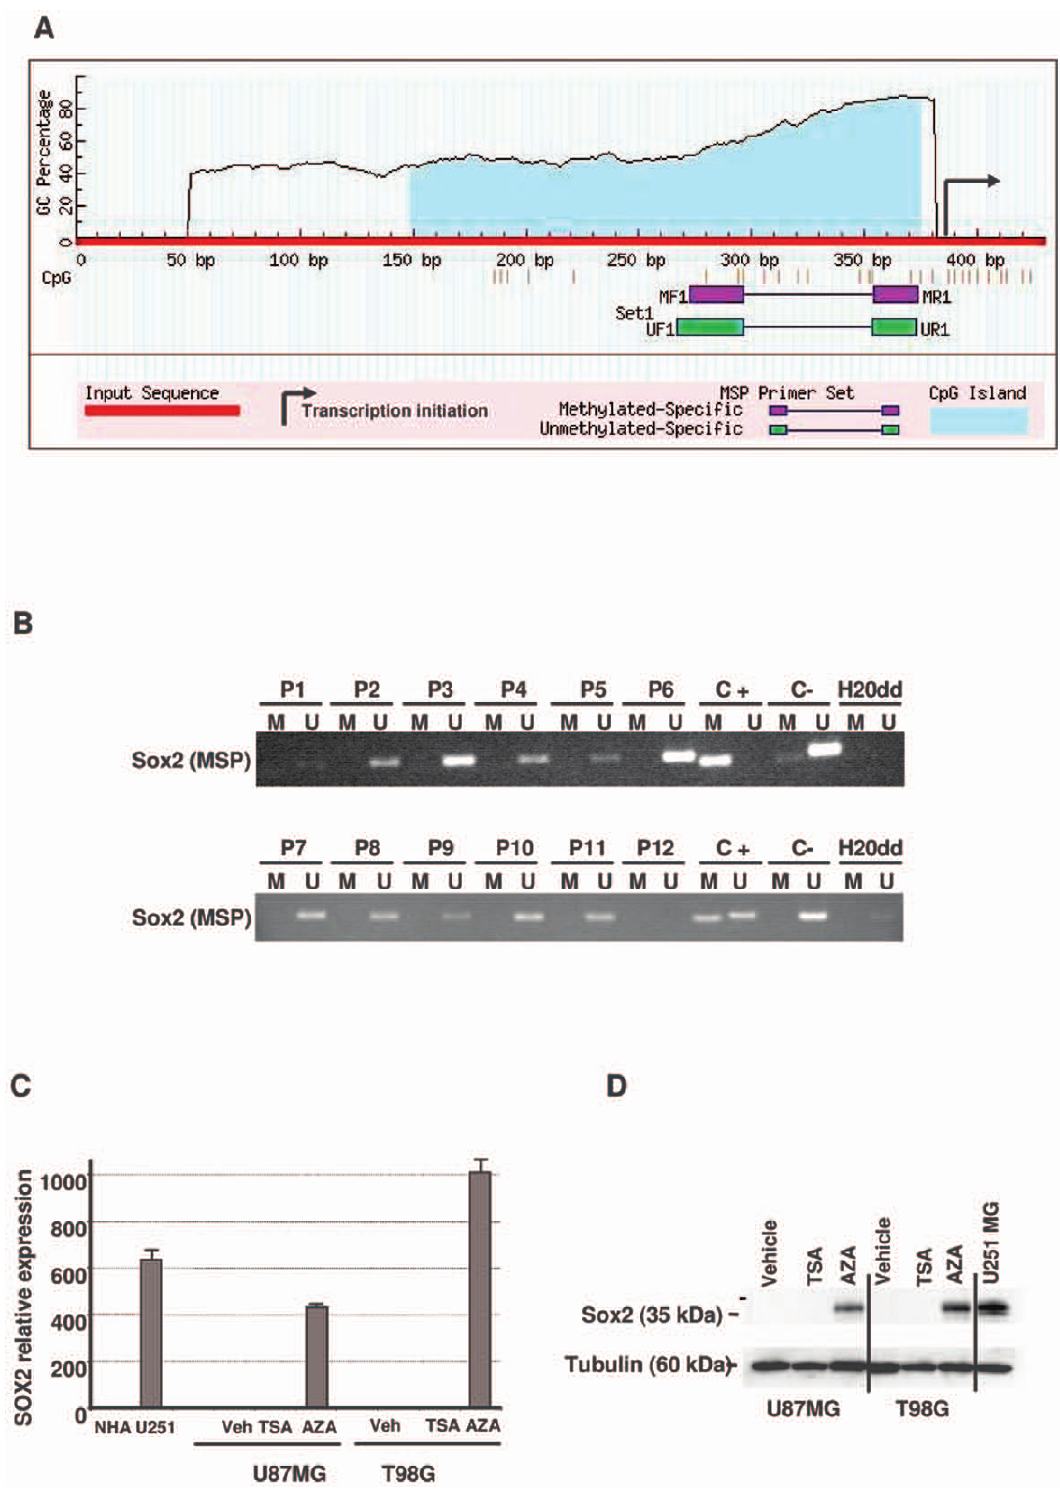
Figure 2. Methylation analysis of the Sox2 promoter gene. A. Analysis of the Sox2 promoter CpG content. The position of the Sox2 promoter CpG island is shown. The vertical tic marks denote the CpGs in the island, and the position of the DNA methylation assay with MSP primers is shown. B. MSP analysis of the promoter CpG islands of Sox2 in 12 patients with GBM. PCR products recognizing unmethylated (U) and methylated (M) CpG sites were analyzed on 2% agarose gels. C + =positive control; in vitro methylated control, C 2 =negative control; DNA from normal brain and ddH 2 O=water control containing no DNA. C. Relative expression of SOX2 mRNA following treatment with either vehicle (Veh), Trichostatin A (TSA), or 5-aza-2 9 -deoxycytidine (AZA;). Data were averaged from three independent experiments. Normal human astrocytes (NHAs) and U251 MG cell line were used as negative and positive controls, respectively. D. Analysis of the expression of Sox2 protein following the same treatment described in C. Data were averaged from three independent experiments. The U251 MG cell line was used as positive control.